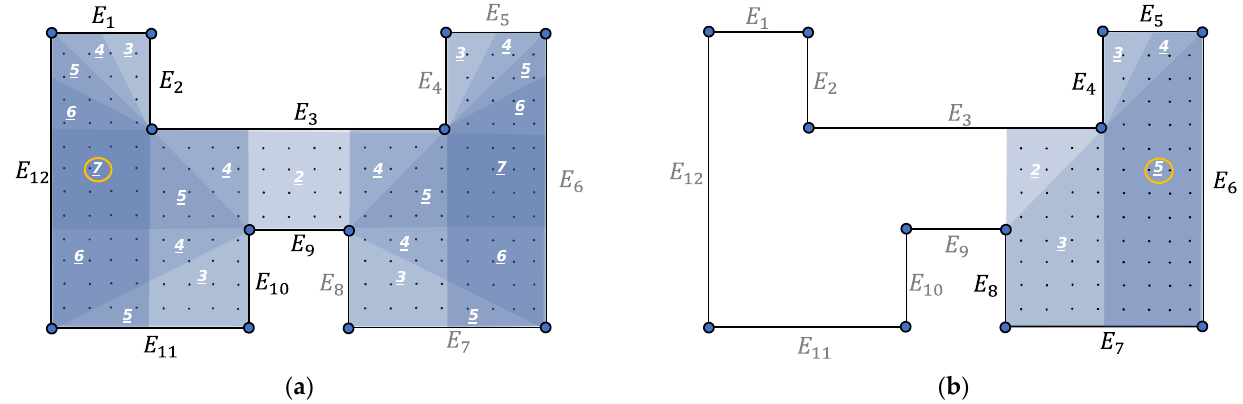
Figure 5. Find the optimal viewpoints. ( a ) First viewpoint selection based on the initial heatmap; ( b ) updated heatmap after selecting a viewpoint.